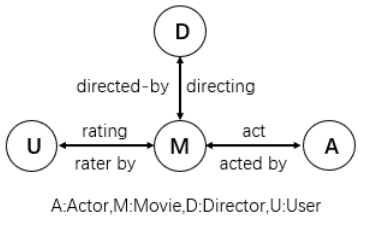
Figure 4. The network pattern of MovieLens 1m and